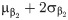
Heatmap of the ranked transcript clusters (TCs) with stronger effect as response to the intervention.Heatmap of the TCs with stronger effect as response to completed distance in the Ultra Marathon Trail (UMT). Selection was based on β2 values obtained in the linear model. Those TCs with abs(β2) > μβ2+2σβ2 were chosen corresponding to 1,115 among the 5,499 differential TCs.